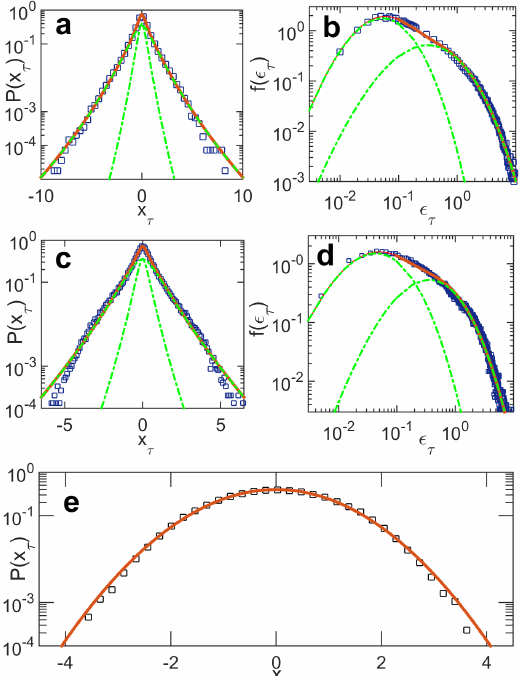
Figure 3. Distributions of intensity increments P ( x τ ) and background density f ( (cid:101) τ ) for RFL emission spectra separated by τ units of time that are ( a , b ) first neighbors ( τ = 1 ) , ( c , d ) second neighbors ( τ = 2 ) , and ( e ) distant neighbors ( τ = 5000 ) . The theoretical results (red lines) adjust quite well to the experimental data (squares), with the mixture components shown in green dashed